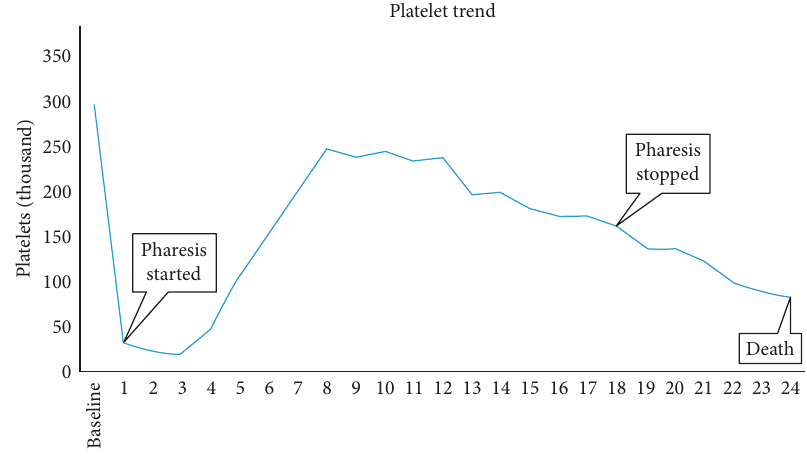
Figure 1: Graphic trend of platelet count over the course of hospitalization. Baseline platelets were normal (298 found to be acutely low at 32 10 9 /L on admission (hospital day 1) with recovery to 248 ×